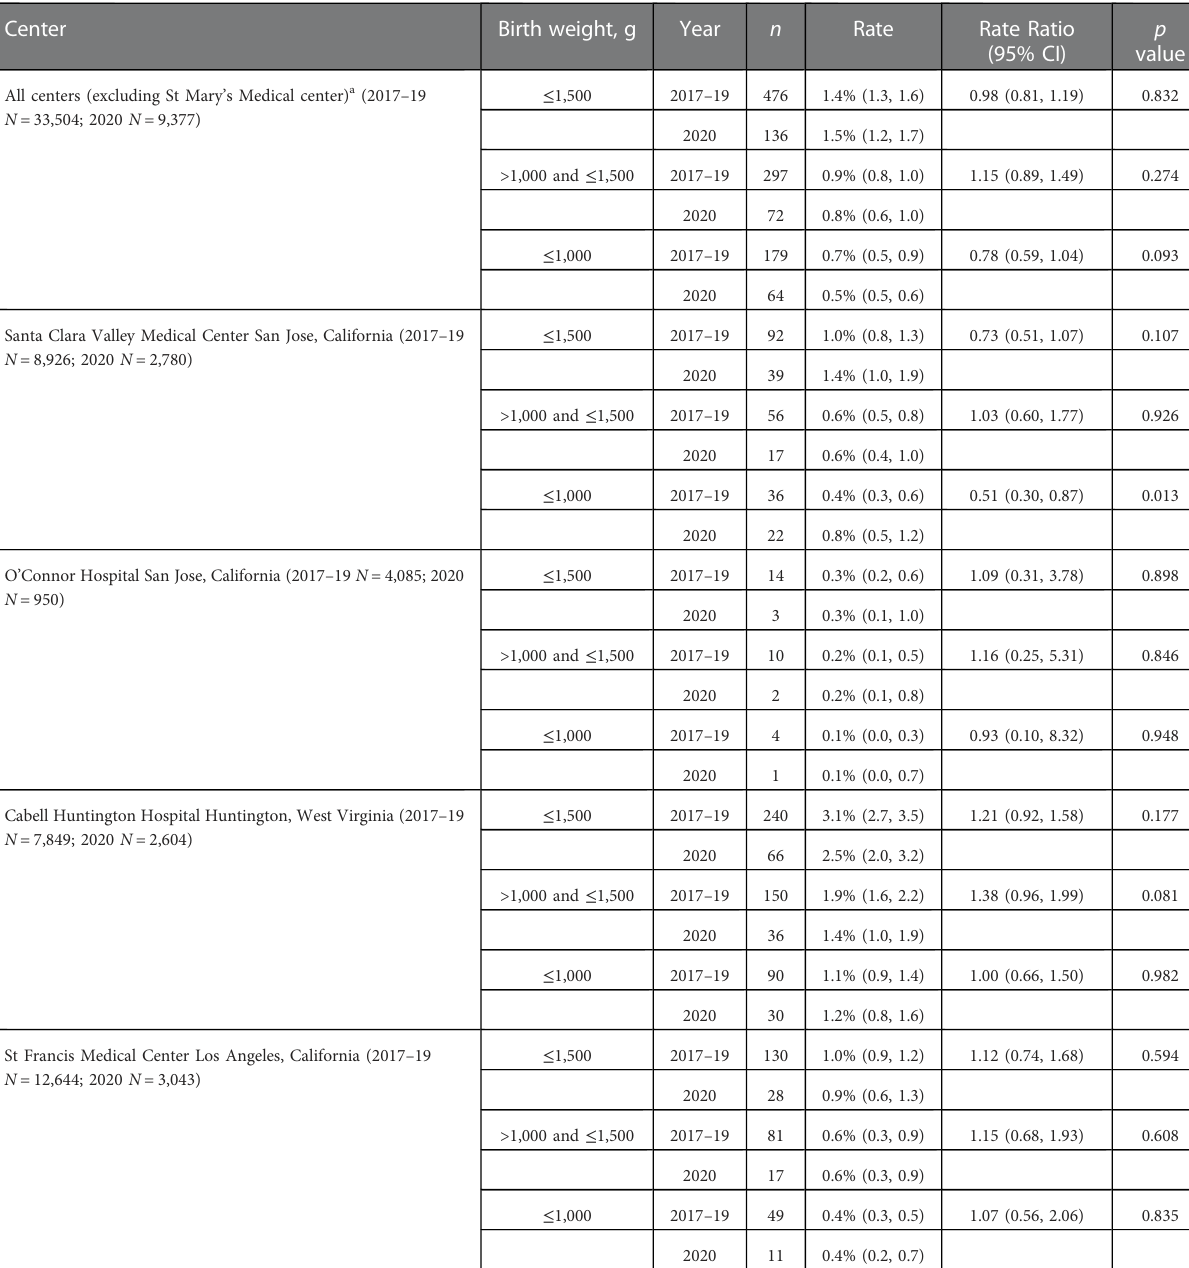
TABLE 2 Comparison of pre-COVID era (2017 – 2019) vs. COVID era (2020) low birth weight rates across fi ve medical centers strati fi ed by birth weight. Center Birth weight,